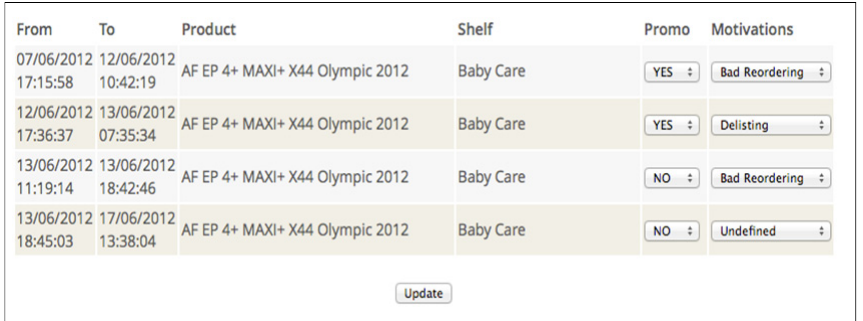
Figure 12. User interface to select the SOOS motivations.